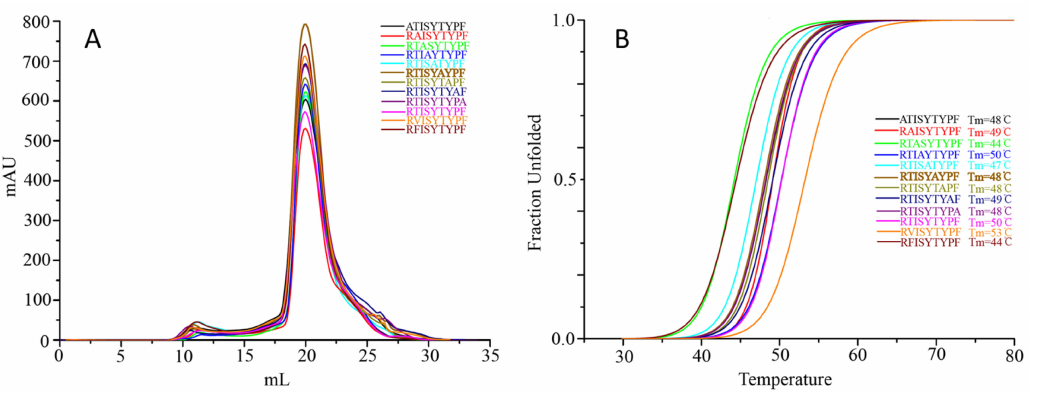
Figure 7. Peptide-induced assembly and pDLA-88*001:04 complex stability were tested using RTI9 peptide and several peptides derived thereof and in vitro refolding. ( A ) Gel filtration chromatograms of the refolded products. The main peaks represent the correctly refolded pDLA-88*001:04 complexes. ( B ) Thermal stabilities of the pDLA-88*001:04 complexes. Complexes of DLA-88*001:04/ β 2m bound to RTI9 or one of 11 mutant peptides were tested by CD spectroscopy. The denaturation curves of the complexes with the different peptides are indicated in different